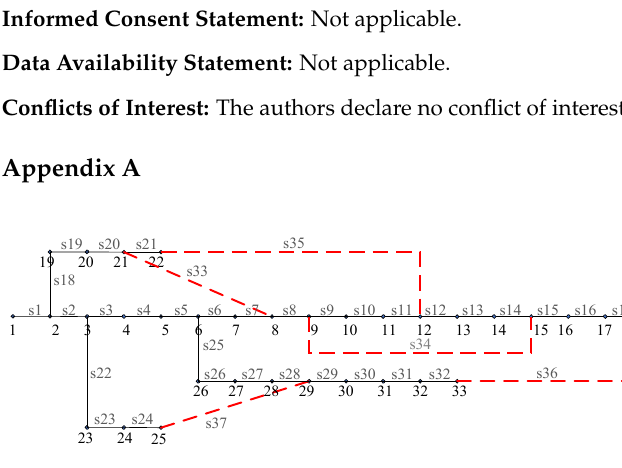
Figure A1. IEEE 33-bus system.